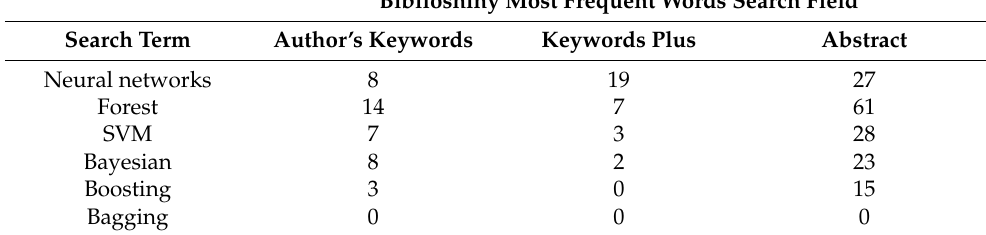
Table 1. Machine learning methods to conduct event history analysis in a Web of Science query, by biblioshiny search